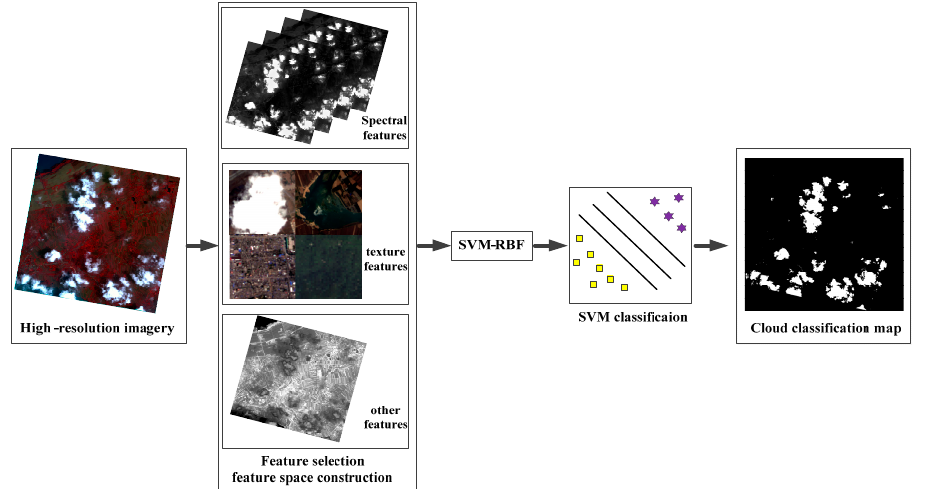
Figure 4. Diagram showing the method used to combine multiple features.